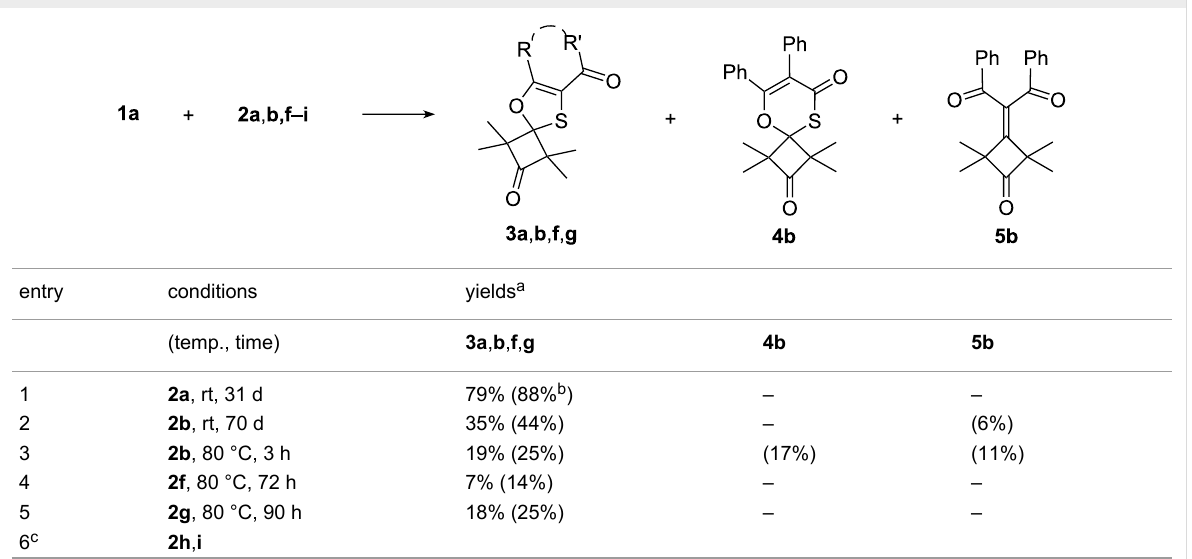
Table 1: Reactions of diazodiketones 2 with thioketone 1a .